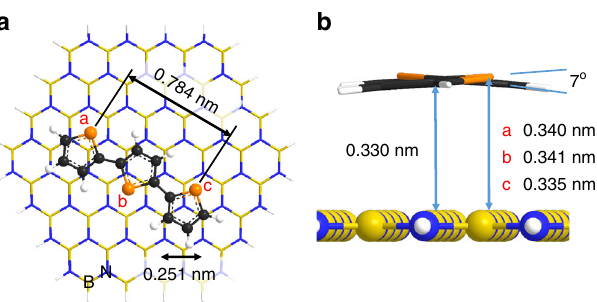
Fig. 2 Calculated structures of trans -gauche conformation of terthiophene adsorbed on a hBN slab. a Top view and b side view along the molecular axis showing rotational distortion of the molecule. Both the calculated torsional angle between thiophene units and the molecule – substrate distances are shown